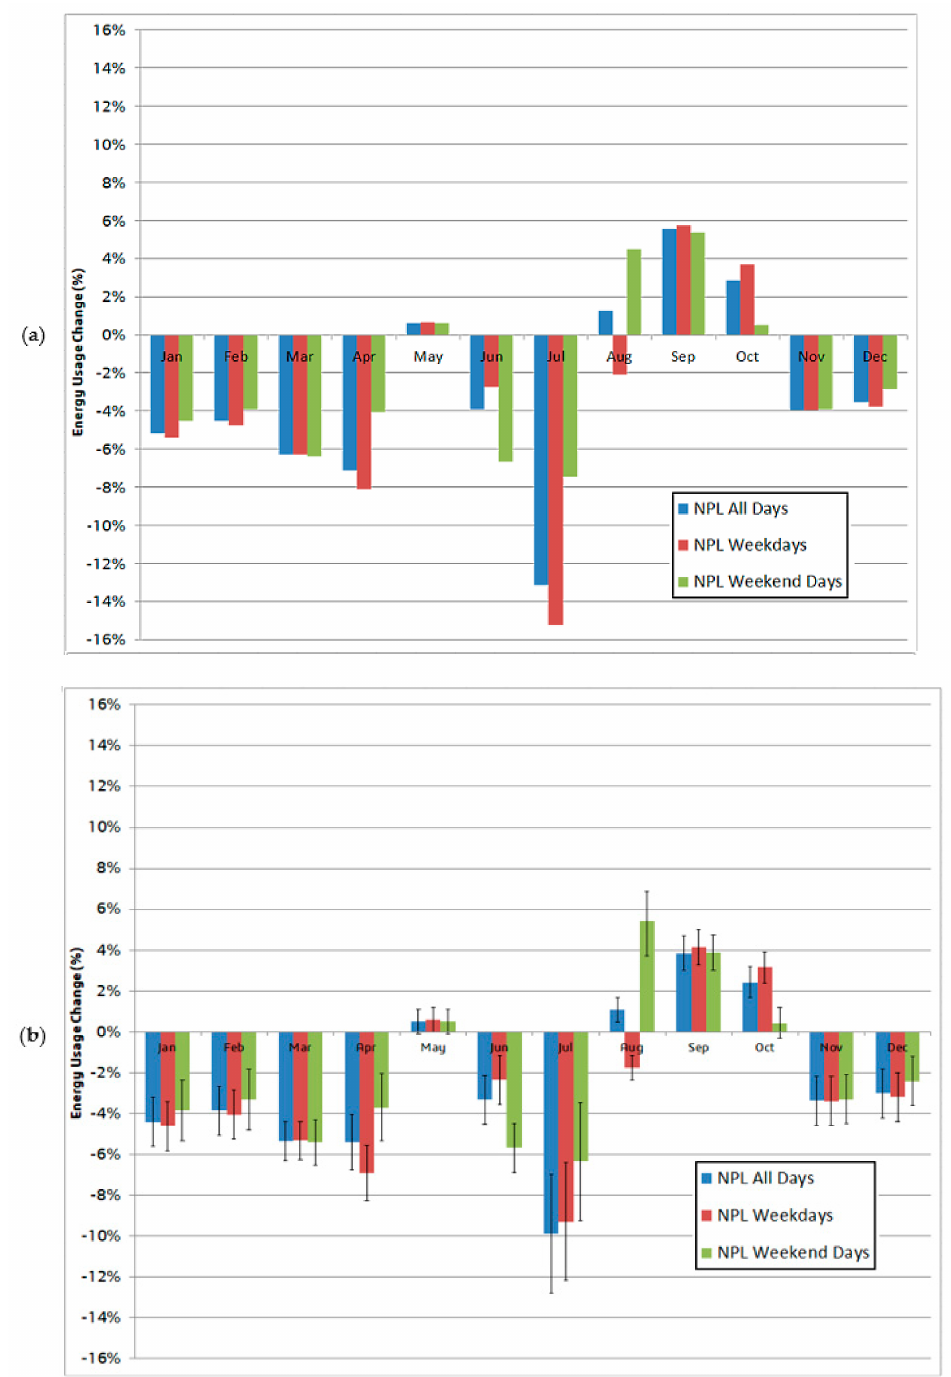
Figure 3. Monthly net load (NPL) including residential and commercial customers for Los Angeles Department of Water and Power for the pandemic compared to a counterfactual model using a 2018–2019 baseline. ( a ) Presented without temperature correction, and ( b ) presented with normaliza- tion to MST against a corresponding monthly counterfactual value, showing 80% CI boundaries in error bars as a result of temperature